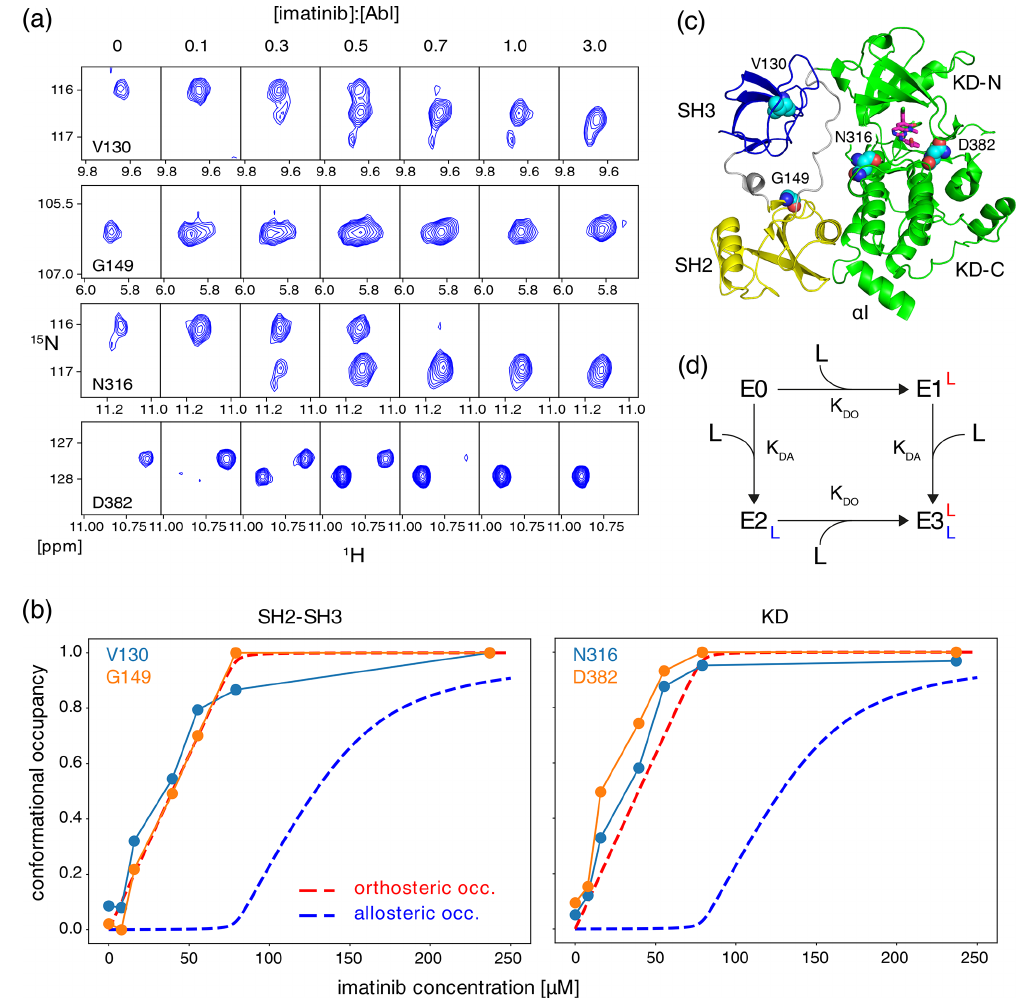
Figure 2. Correlation between imatinib binding to the Abl ATP site and imatinib-induced Abl core disassembly observed by NMR. (a) In- dividual 1 H– 15 N TROSY resonances of selected residues of the Abl 83–534 core, which show characteristic shifts for the apo and imatinib- bound state, as a function of imatinib concentration ([Abl 83–534 ] = 79µM). Molar ratios of imatinib vs. Abl 83–534 are given above the panels. (b) Occupancies of Abl 83–534 states as a function of imatinib concentration derived from resonance intensities in (a) . Predicted imatinib oc- cupancies of orthosteric (red) and allosteric pockets (blue) according to the equilibrium model (d) are shown as dashed lines for parameters [Abl 83–534 ] = 79µM, K DO = 10nM, and K DA = 10µM. (c) Crystal structure of Abl regulatory core (PDB ID: 2FO0) in complex with ATP- site inhibitor PD166326 (magenta sticks) showing the locations of residues V130, G149, N316, and D382 (cyan spheres) whose resonances are analyzed in panels (a) and (b) . (d) Chemical equilibrium model describing the binding of the imatinib ligand (L) to Abl’s allosteric (dissociation constant K DA ) and orthosteric (dissociation constant K DO ) binding sites. E0–E3 present Abl apo and various imatinib-bound